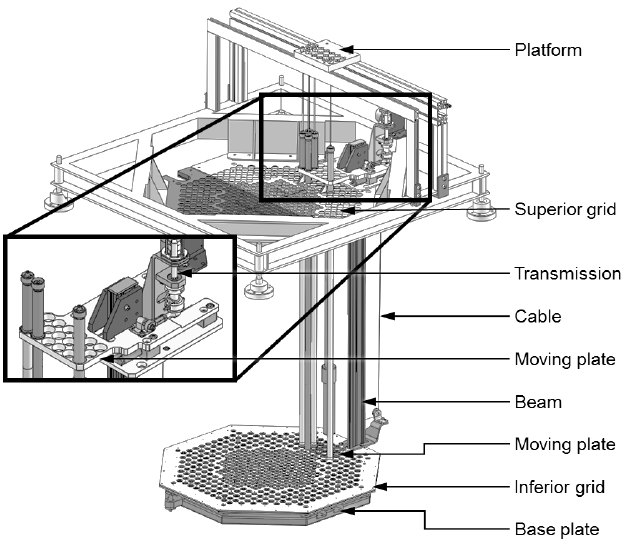
Fig. 2. Overview of the fuel rods oscillator with core structures and a few rods inserted in the device, and details of the top part with moving plate and motor.